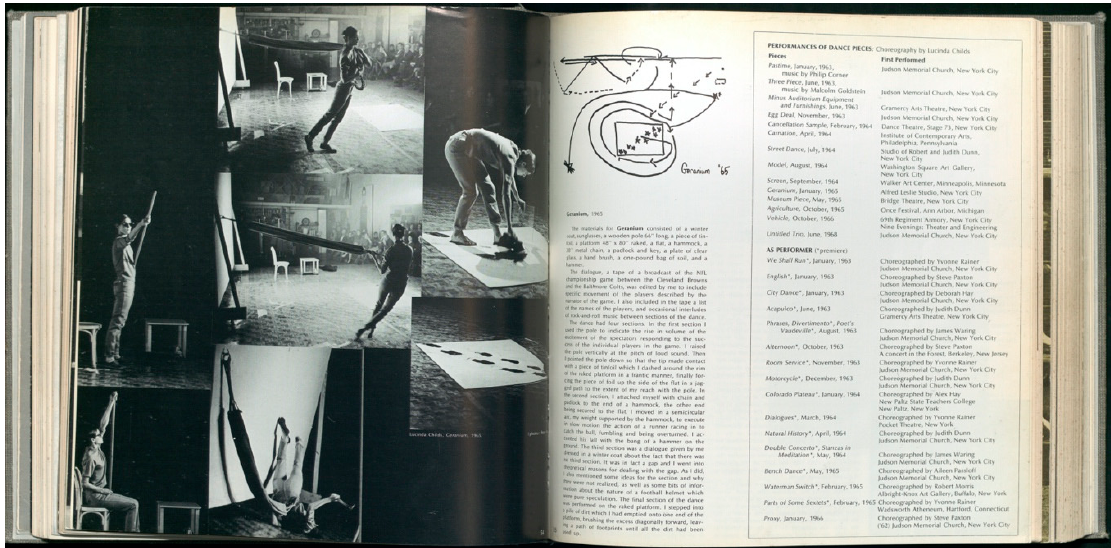
Figure 5. (Childs 1973, pp. 54–55), black and white print, 10.6” × 10.6” ©